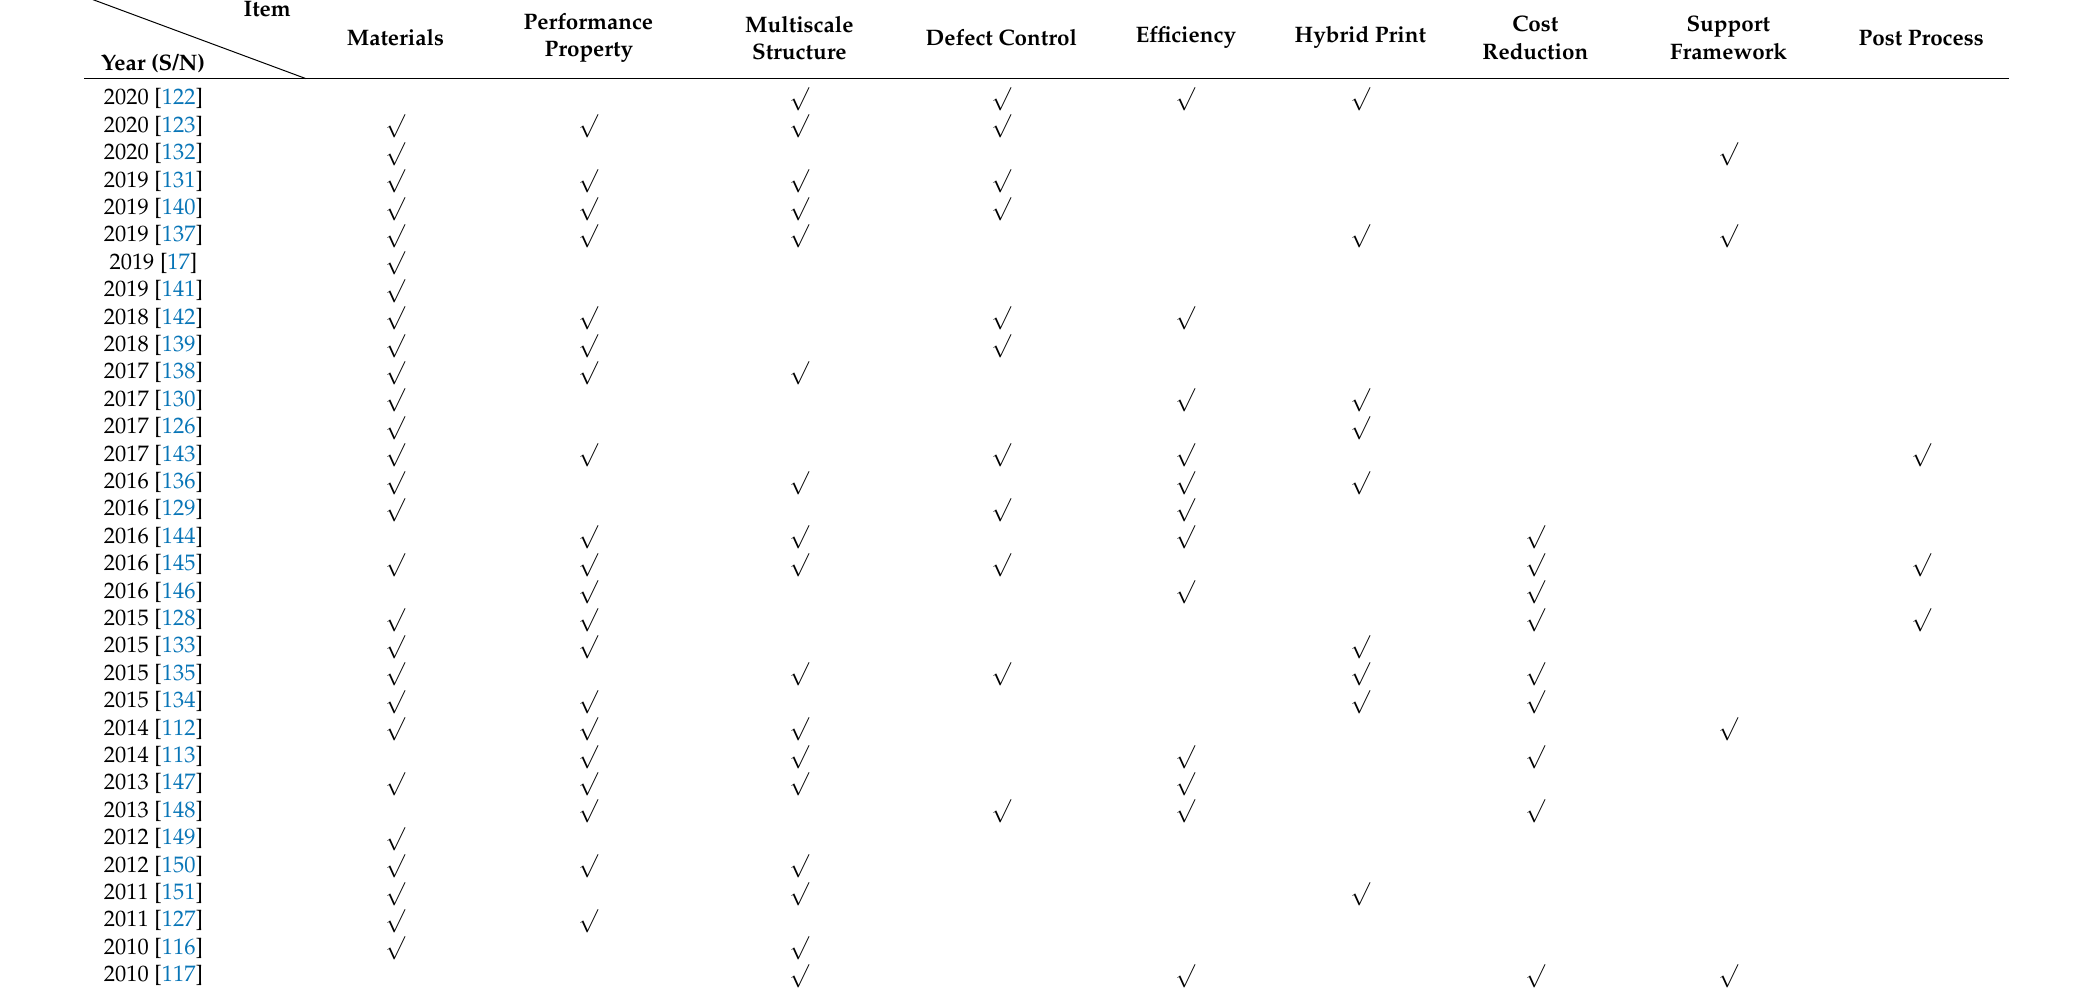
Table 8. Technical contents of 3D printing related